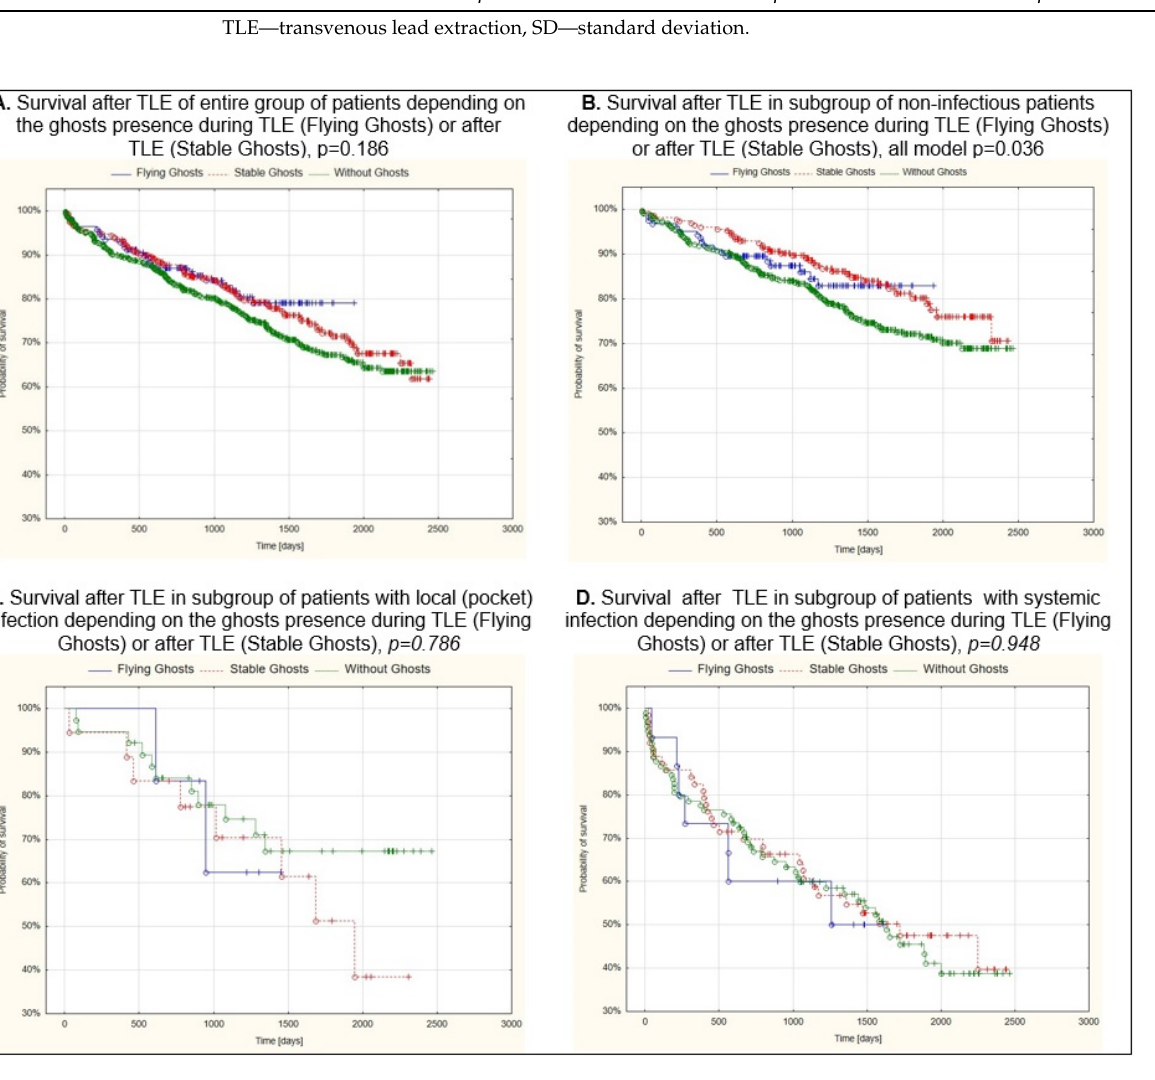
Figure 6. Kaplan–Meier probability of survival after TLE based on the presence of ghosts during or after TLE. Table 4. Factors influencing long-term prognosis after TLE, results of uni- and multivariable Cox regression analysis.